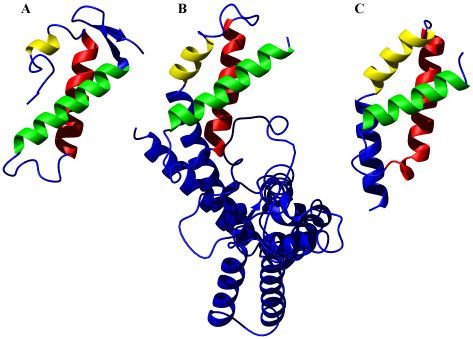
Comparison of ChaB with structurally similar proteins. Structural similarities between (A) ChaB, (B) σ70(PDB code 1SIG [14]) and (C) σRN (PDB code 1H3L, [15]) proteins identified from the DALI server. The three helices in ChaB are colour coded, with the equivalent helices in σ70 and σRN similarly coloured.